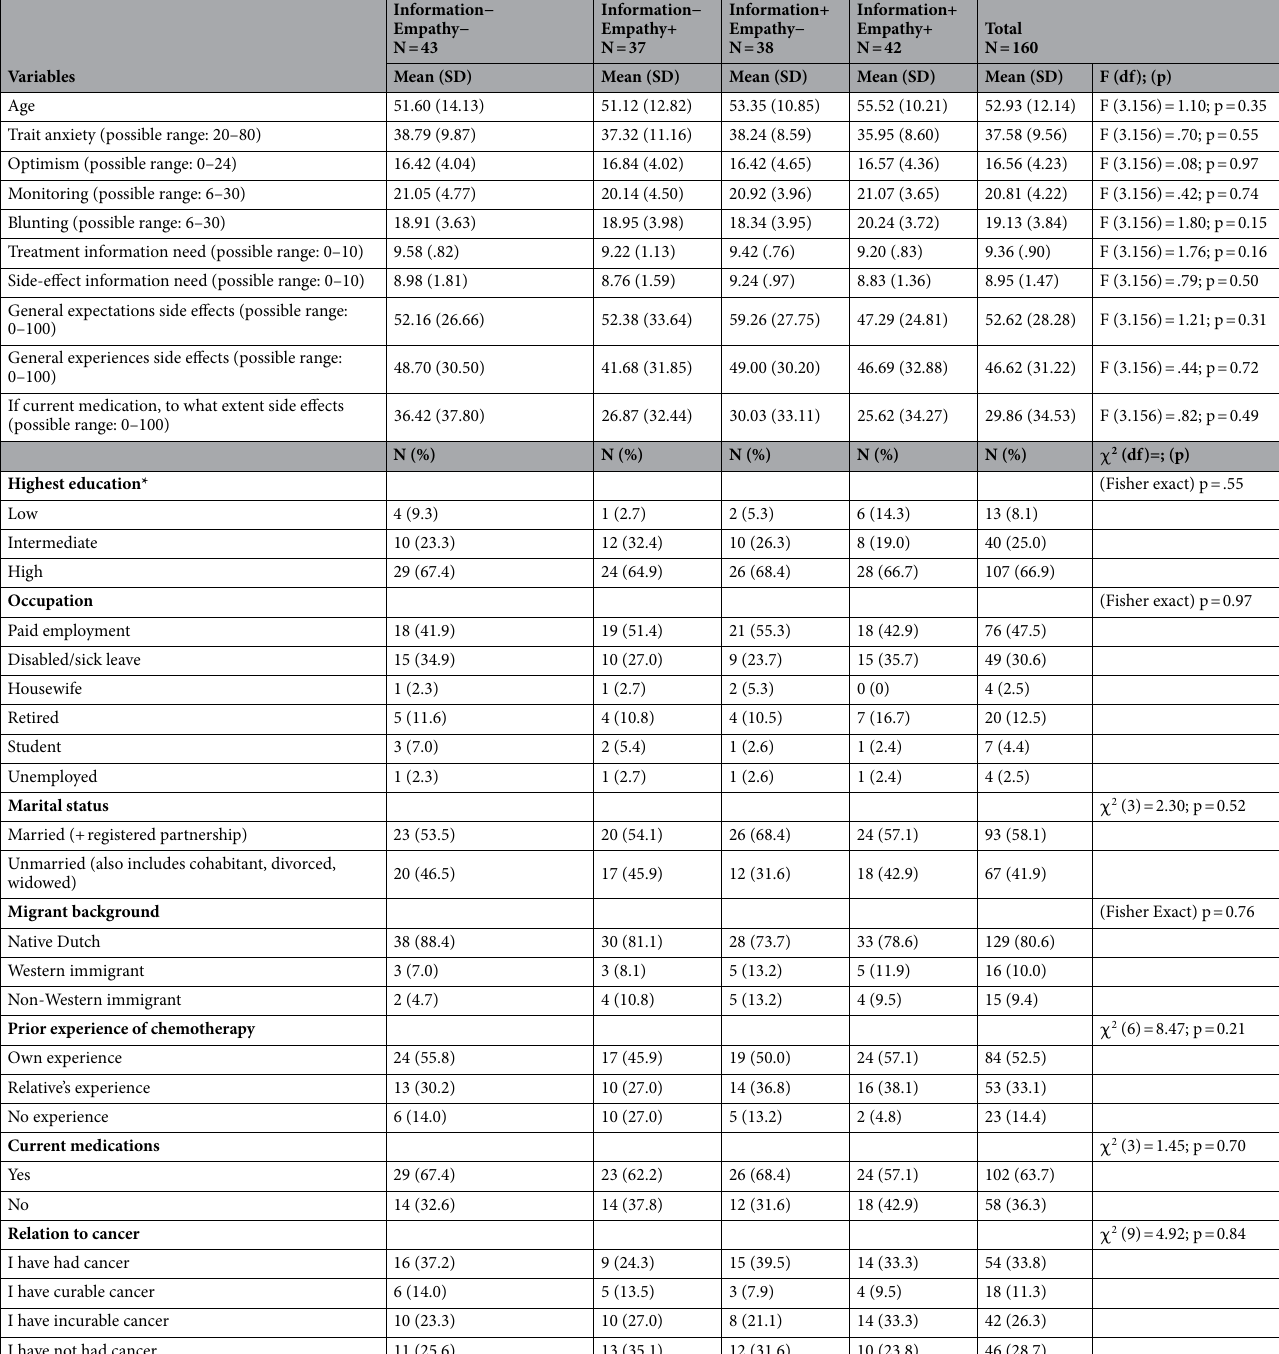
Table 3. Background characteristics of participants (by condition). *Lower education (< secondary school); middle (secondary school + vocational education); high (higher vocational education or